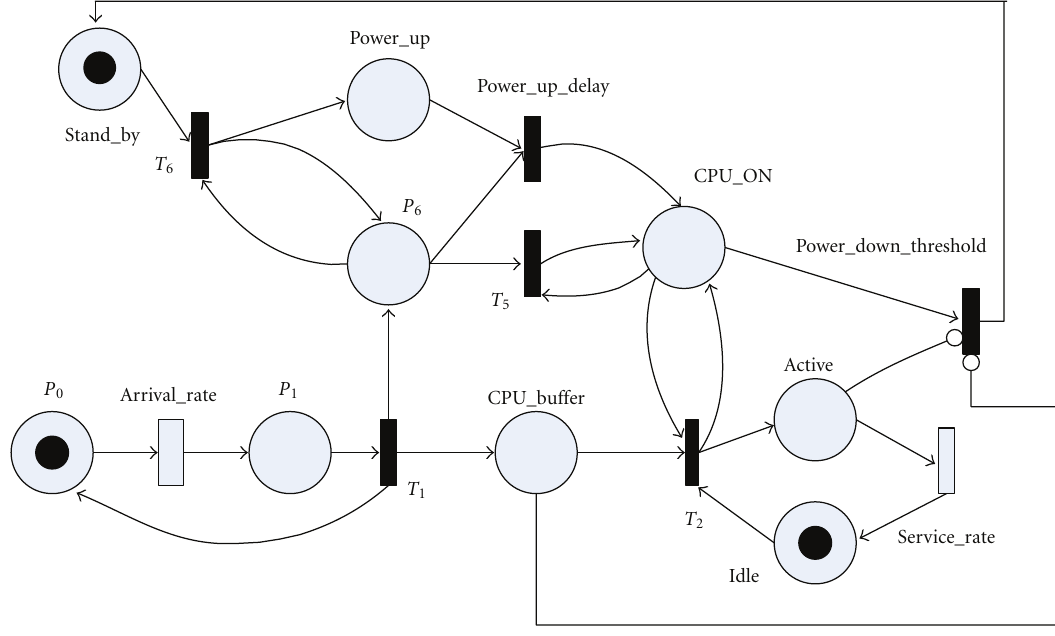
Figure 4: Petri net model of CPU.